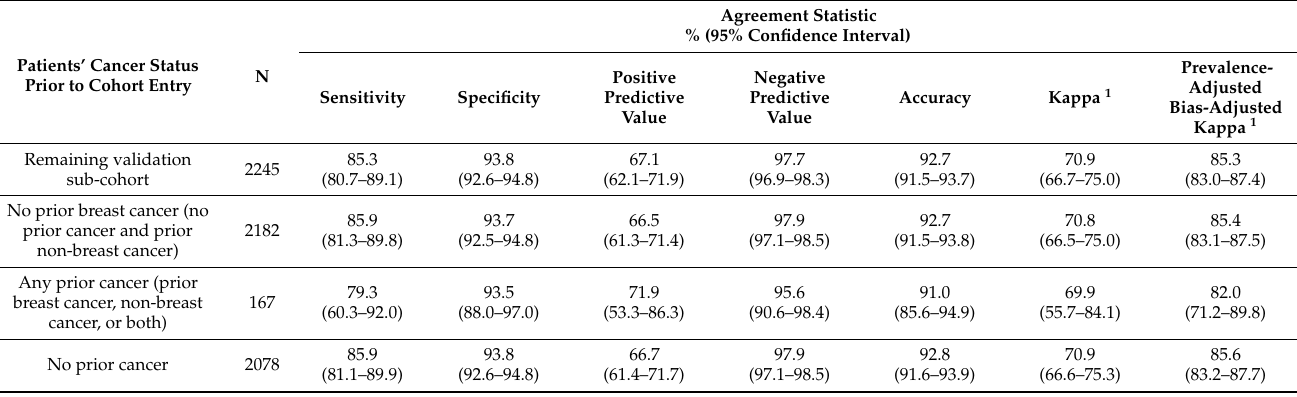
Table A10. Algorithm diagnostic accuracy at classifying patients as experiencing a second breast cancer event (SBCE), stratified by prior cancer